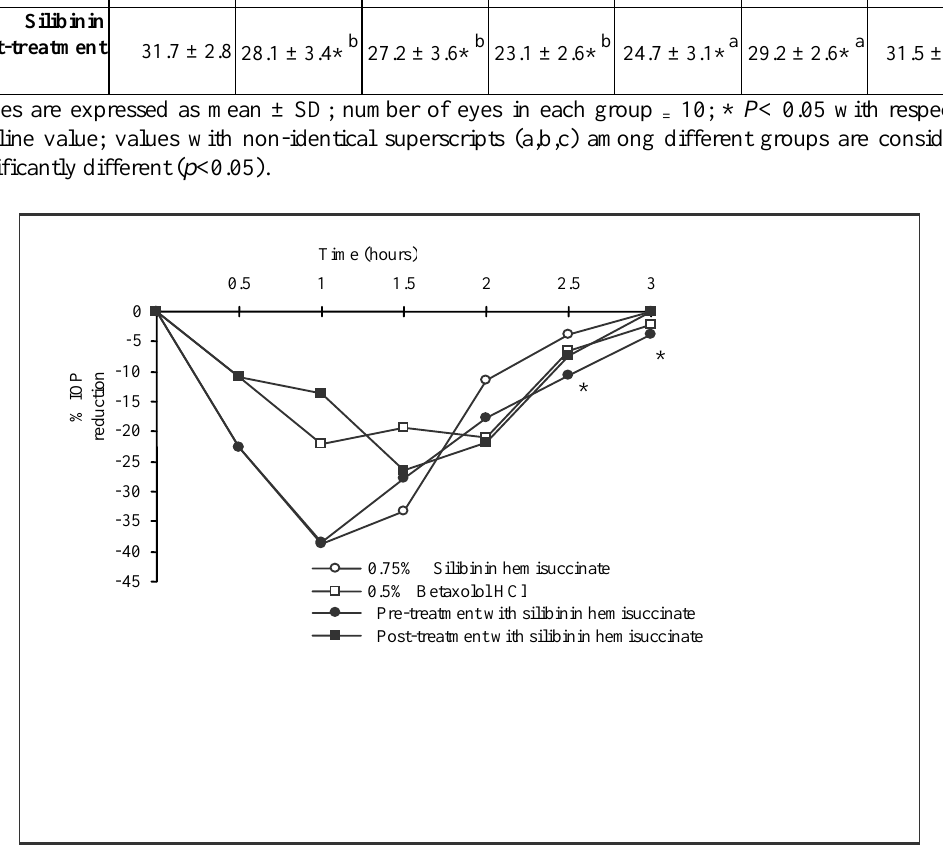
Figure 1. Effects of pre- and post- treatment with 0.75% silibinin hemisuccinate on IOP-lowering effect of 0.5% betaxolol in normotensive rabbits; results are presented as mean of % reduction; number of eyes in each group 10; *P<0.05 with respect to 0.75% silibinin hemisuccinate =